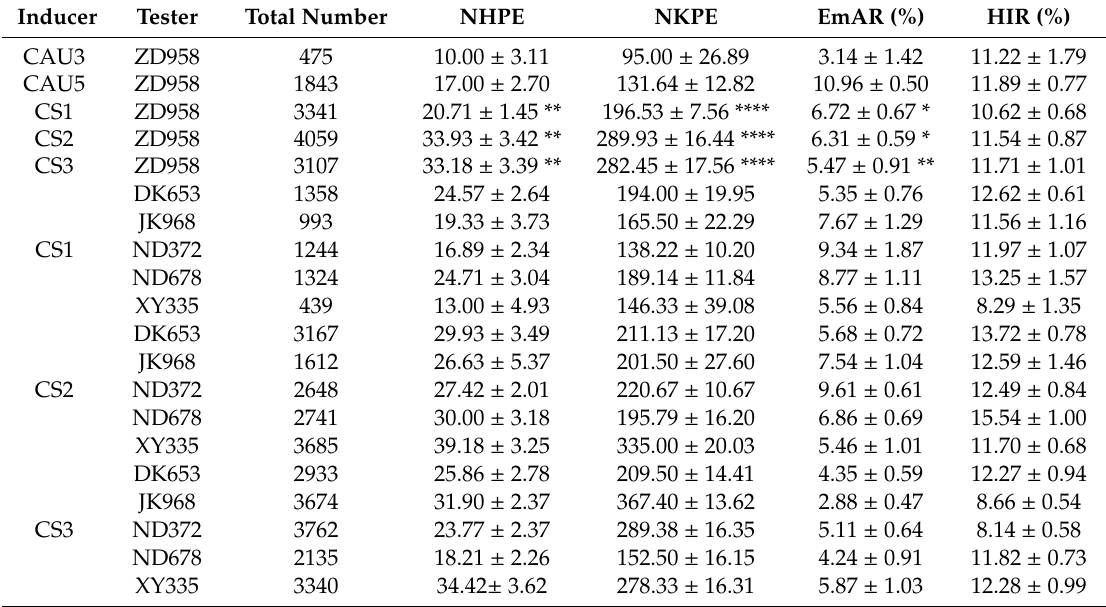
Table 1. Evaluation of the candidate haploid inducer